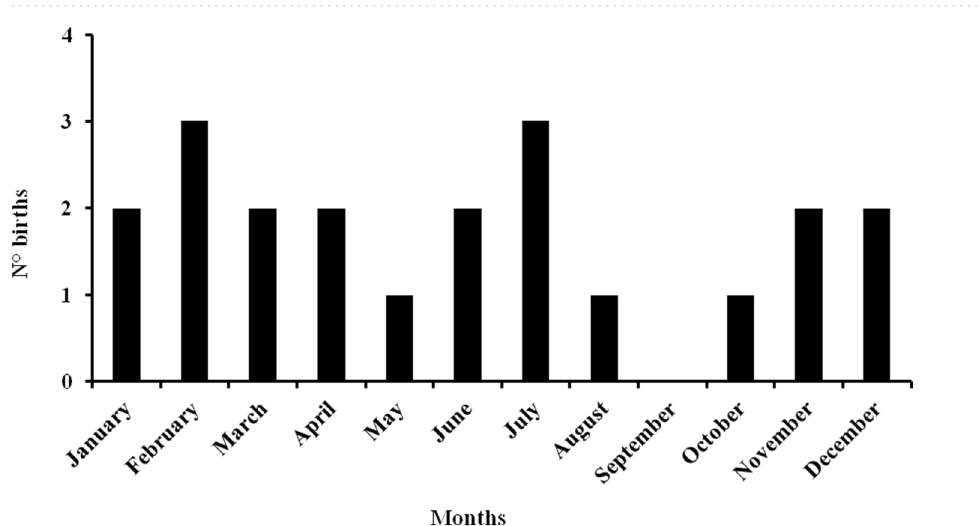
Figure 5. Total number of recorded births per month for all the 8 monitored porcupine pairs during the 3 years of